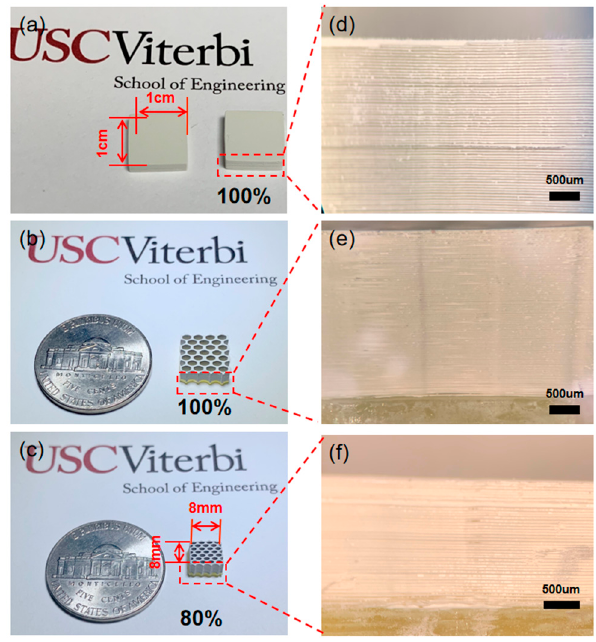
Figure 3. ( a ) Green part sample with brick structure. ( b ) Green part sample with honeycomb structure in 100% size ratio. ( c ) Green part sample with honeycomb structure in 80% size ratio. ( d – f ) Layer details of the green parts under a microscope.